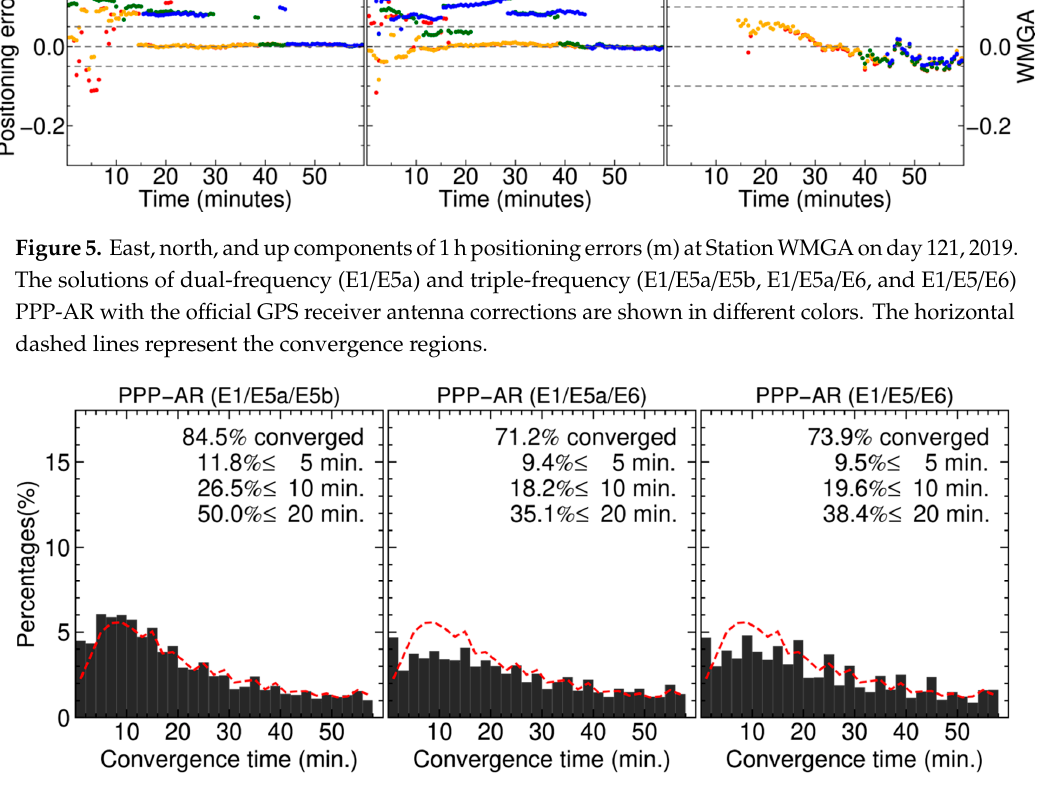
Table 4. Mean convergence time (minutes) of dual-frequency (E1/E5a) and triple-frequency (E1/E5a/E5b, E1/E5a/E6, and E1/E5/E6) PPP-AR with the official GPS receiver antenna corrections for solutions with respect to each station. The reduction rate of the convergence time of triple-frequency PPP-AR relative to dual-frequency PPP-AR is shown in brackets.